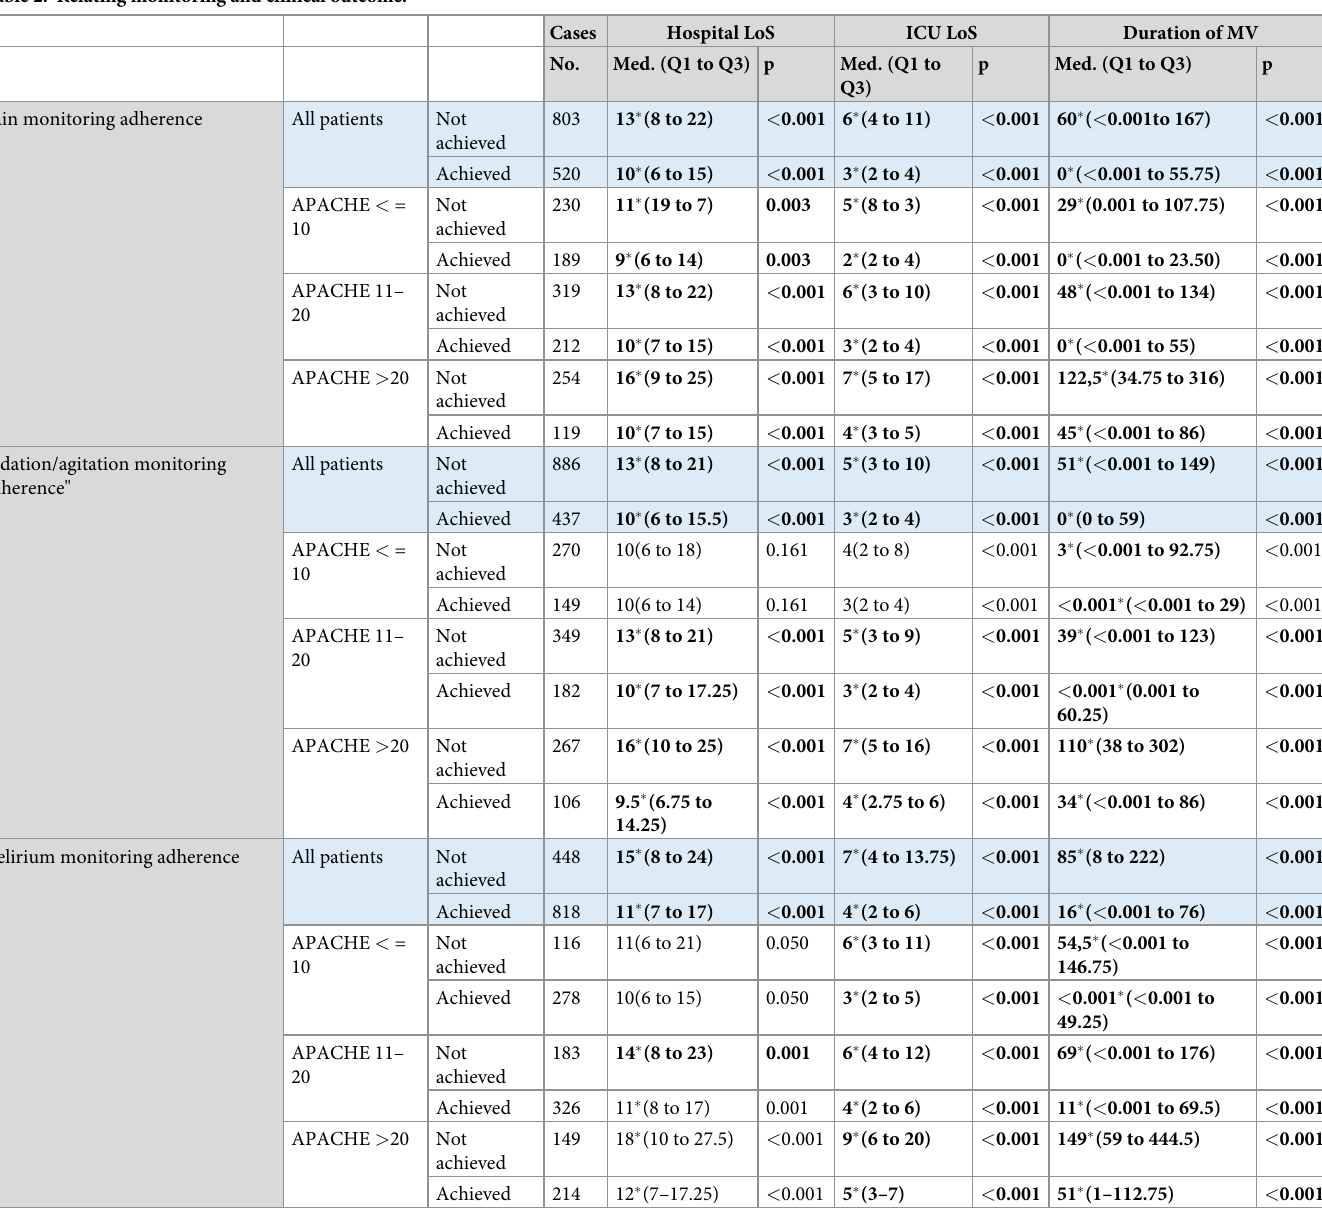
Table 2. Relating monitoring and clinical